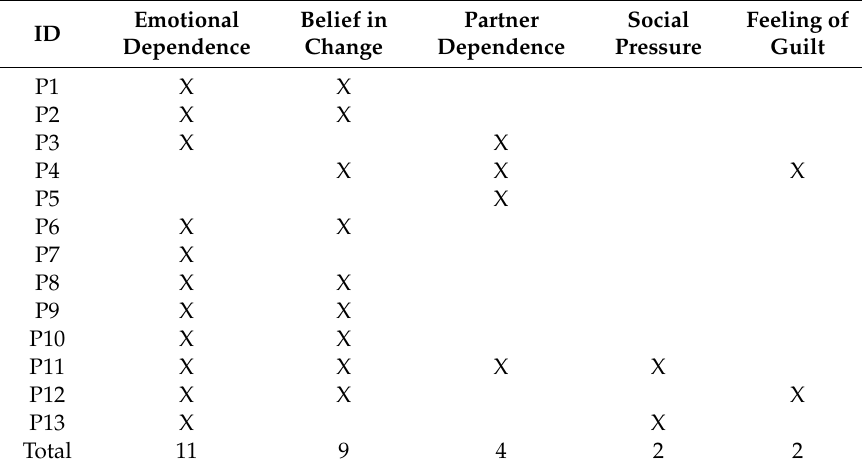
Table 3. Reasons to stay in abusive dating